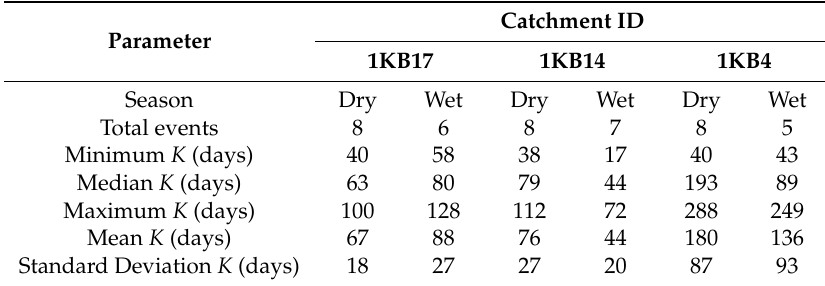
Figure 4. Pumping test-derived aquifer T values related to ( a ) borehole depth, ( b ) aquifer thickness, ( c ) borehole elevation, and ( d ) aquifer hydraulic conductivity, from 27 boreholes (all located in 1KB17 catchment) with no outliers in aquifer T values. Table 4. Summary of recession index ( K ) for dry (December to April) and wet (May to November) seasons across three catchments in Kilombero